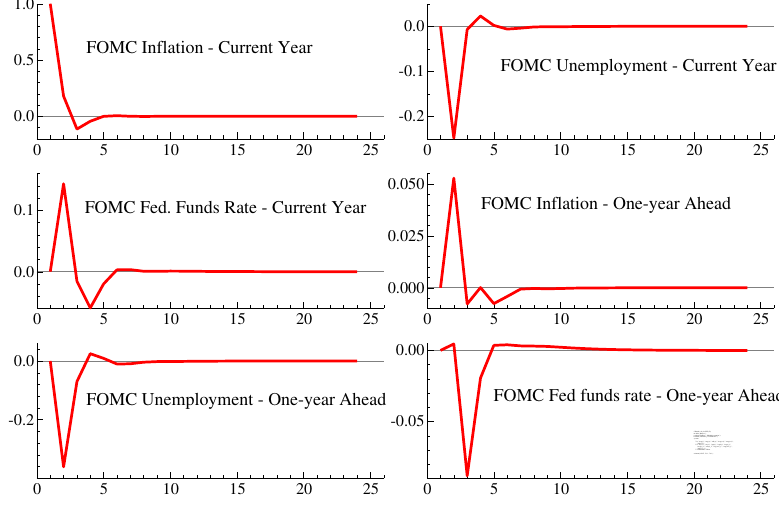
Figure 9. Impulse Responses to a one-percent inflation